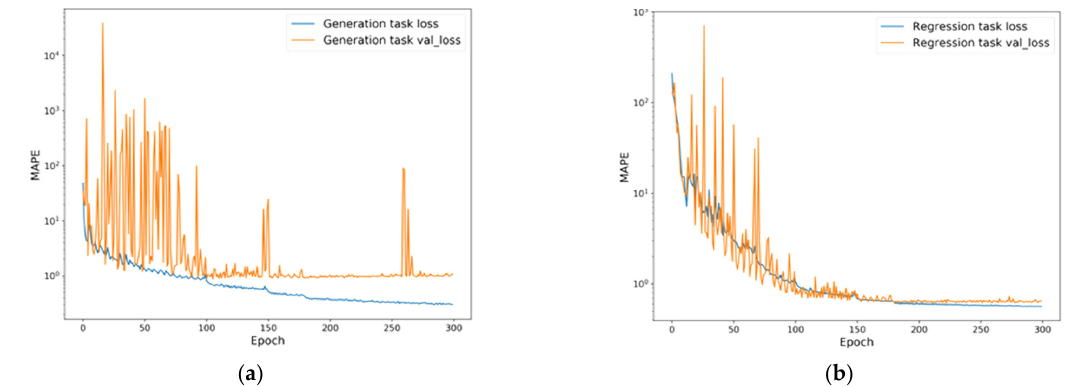
Figure 4. Training curves of the baseline model. Each figure represents training curve of ( a ) generation task; ( b ) regression task.